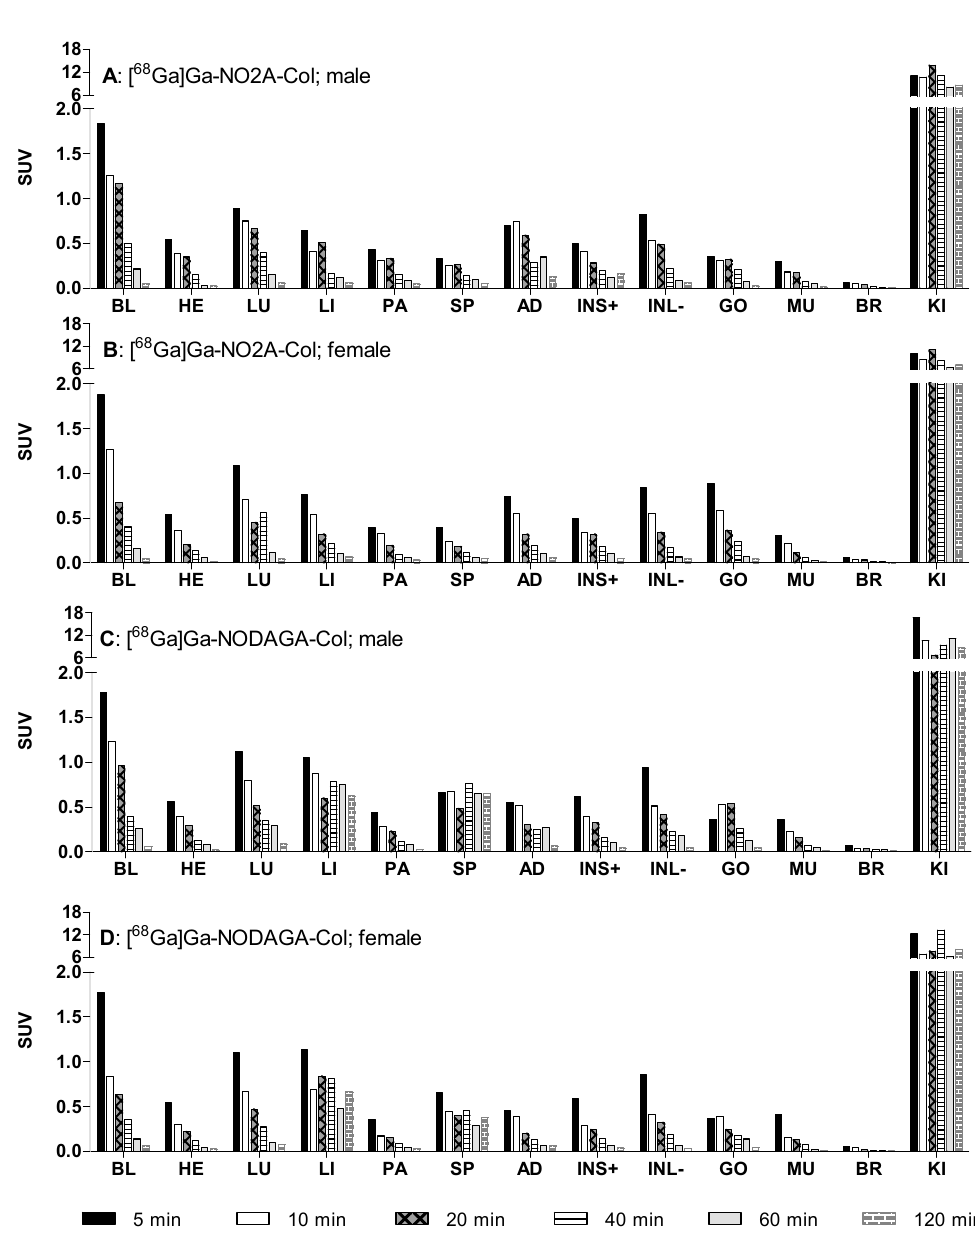
Figure 2. Kinetics of organ radioactivity uptake (standardized uptake value (SUV)) obtained at 5, 10, 20, 60 and 120 min after i.v. administration of [ 68 Ga]Ga-NO2A-Col and [ 68 Ga]Ga-NODAGA-Col in healthy male [2] and female Sprague–Dawley rats. BL: blood; HE: heart; LU: lungs; LI: liver; PA: pancreas; SP: spleen; AD: adrenals; INS+: small intestine with its content; INL: large intestine without content; UB: bladder; GO: gonads; MU: muscle; BO: bone; BM: red bone marrow; BR: brain; KI: kidneys.